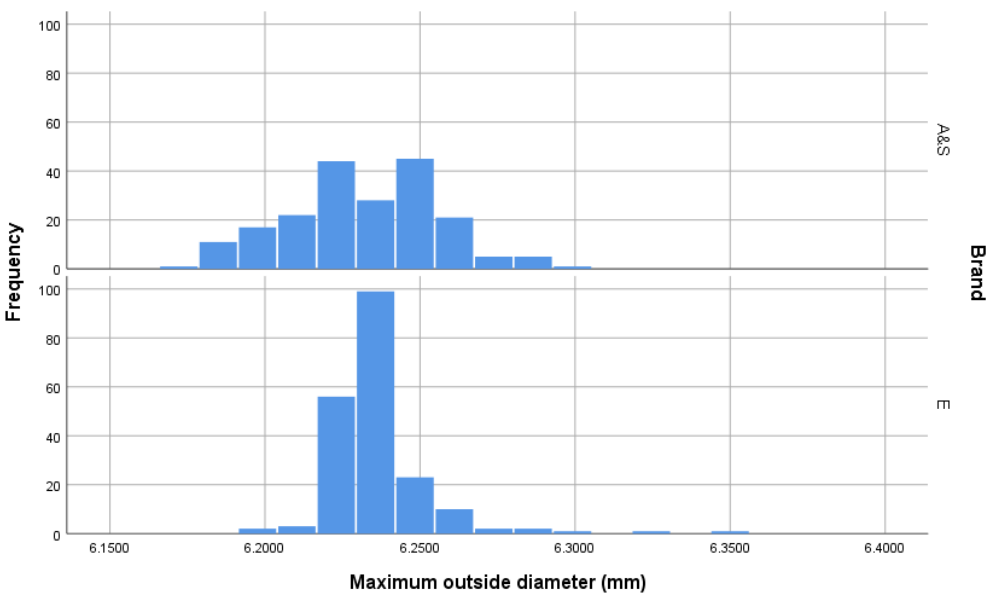
Figure 2. Outer diameter (mm) (OD Outer Figure 1) of cartridges within the sample groups. n = 200 per group demonstrating greater tolerance accuracy in the manufacturing process for Eley (E) cartridges as opposed to Accles and Shelvoke (A&S).